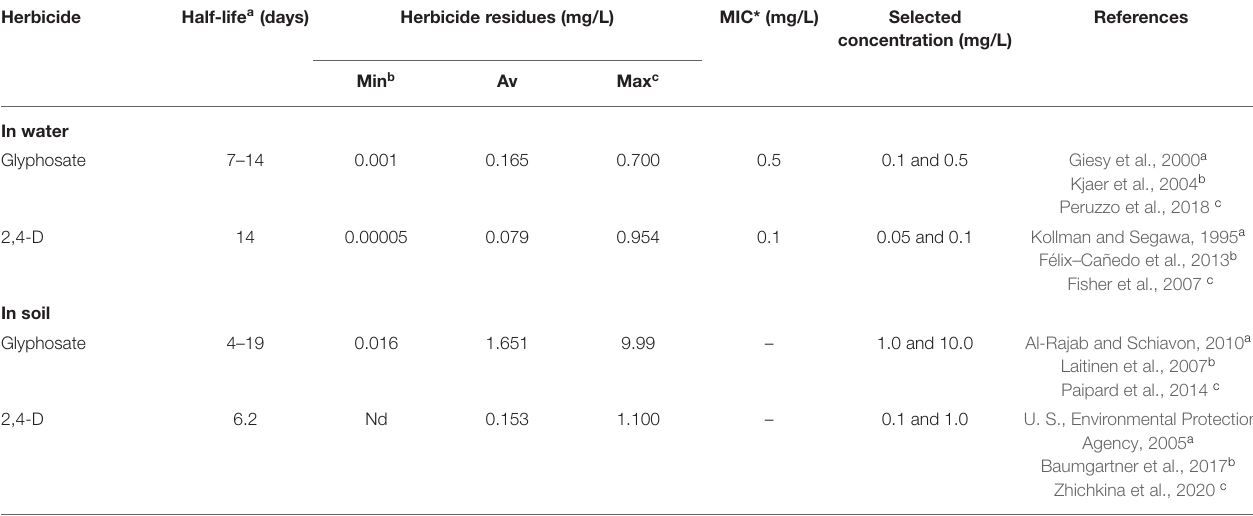
TABLE 1 | Environmentally relevant concentrations of herbicides used in this study.